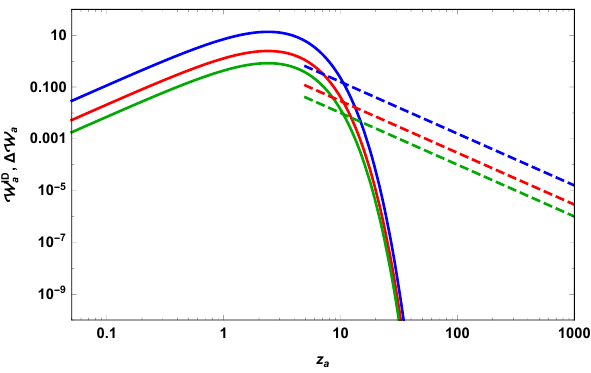
Figure 2 . Pro(cid:12)les W ID (continuos lines) and (cid:1) W a (dashed lines) as a function of z a . The colours a refer to the RH neutrino mass eigenstate in the NO case: the blue (red) [green] continuous line corresponds to the lightest (next-to-lightest) [heaviest] RH neutrino. The lepton number violation scale is (cid:12)xed to (cid:22) L = 10 16 GeV, the lightest active neutrino mass to m light = 0 : 003 eV, which corresponds to z in = 0 : 06, and the coe(cid:14)cients c 1 = c 2 = 0 : 01.